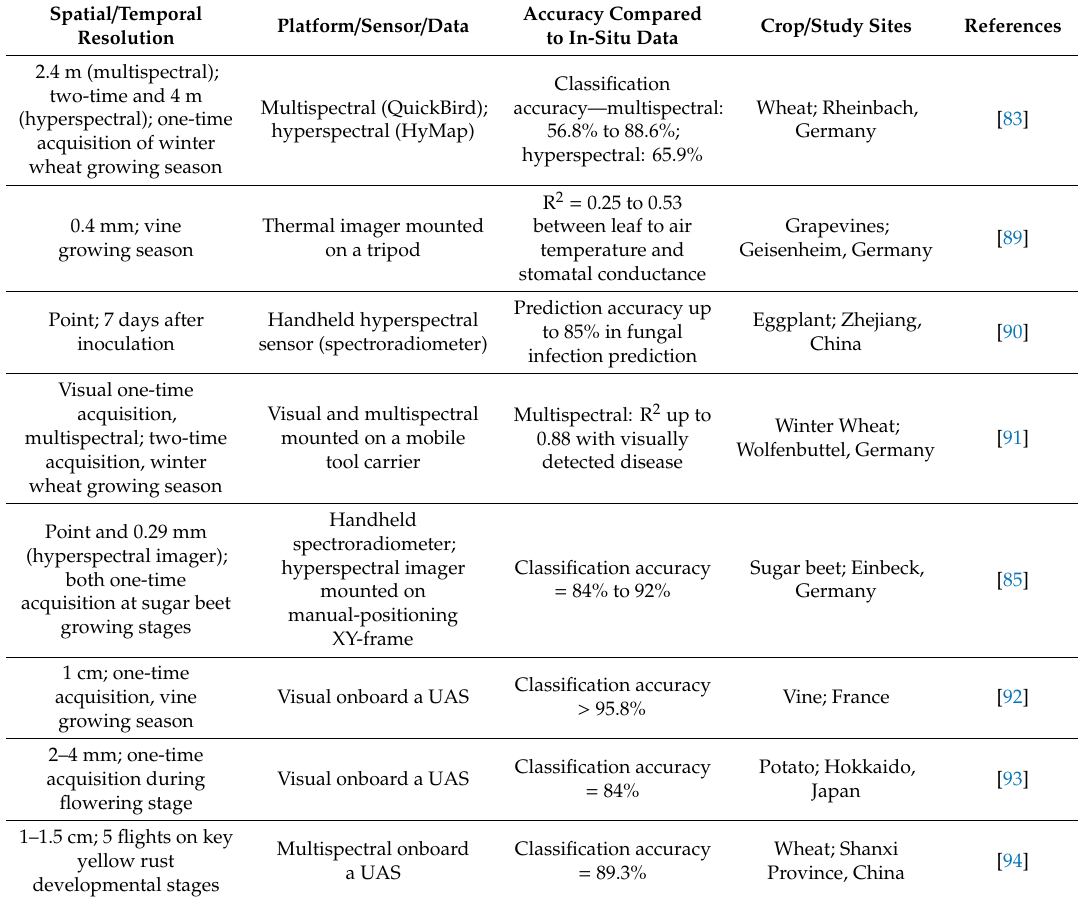
Table 7. Studies conducted for crop disease monitoring using RS data from multiple